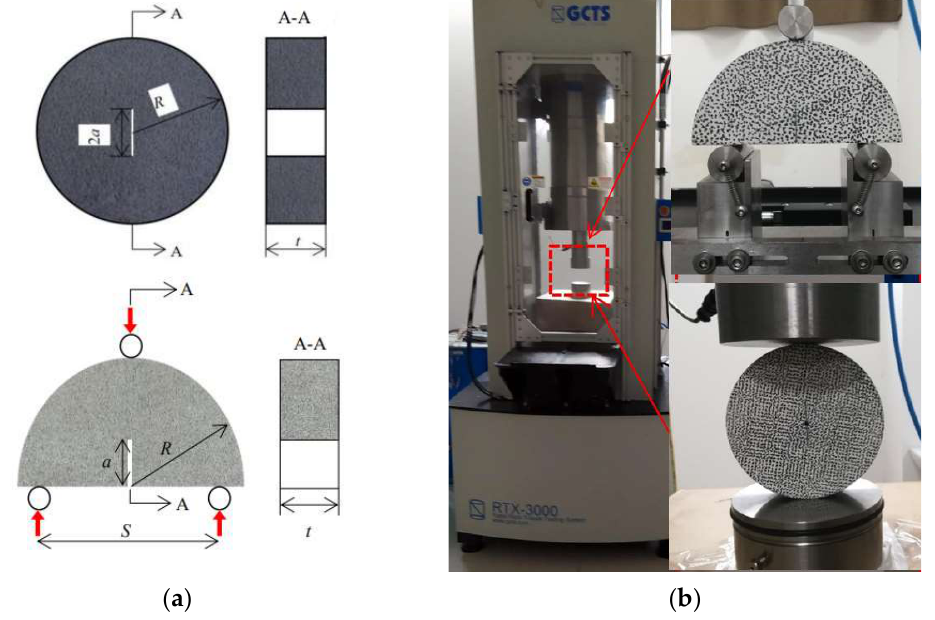
Figure 1. Configuration of rock specimens and testing machine. ( a ) Top: notched semi-circular bending (NSCB) specimens; ( b ) bottom: center-cracked circular disk (CCCD) specimens. Table 1. Physical and mechanical parameters of the tested rocks [21,22].